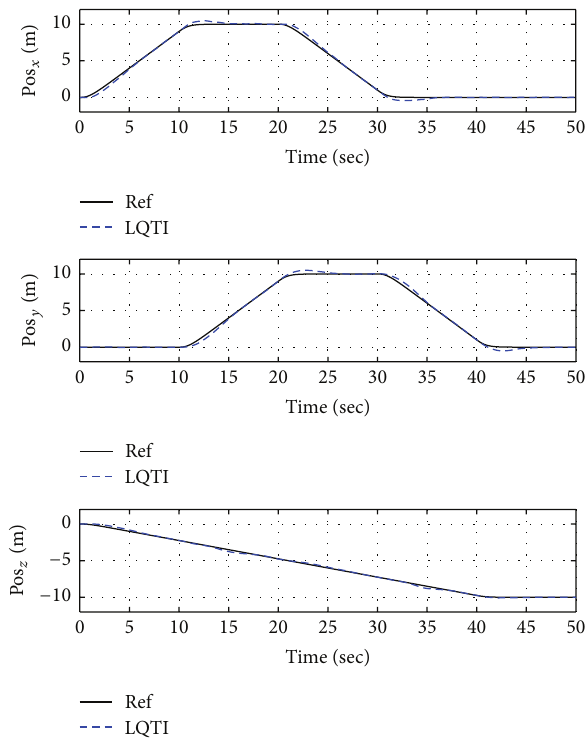
Figure23:Timehistoriesofvelocityatcruisemode(Case 2).Cruise mode (15m/s).